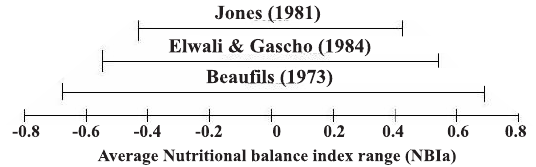
Figure 2. Diagram of the sufficiency interval defined by the NBIa according to the different DRIS